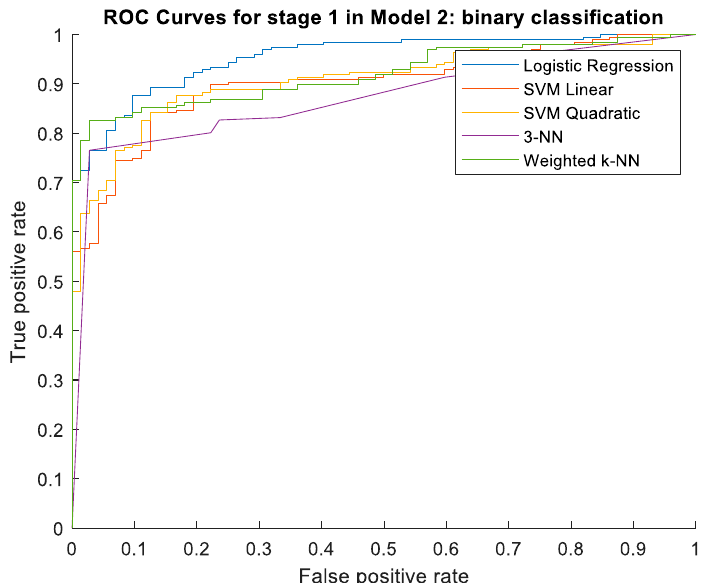
Figure 6. ROC Curves for stage 1 in Model 2 for the different algorithms: binary classification. In the second stage of Model 2, a multi-classification, similar to the one in Model 1, is applied. As the aim of this stage is to refine the diabetic classification, only thermograms of diabetic individuals are used and the same three classes used in Model 1 are considered.